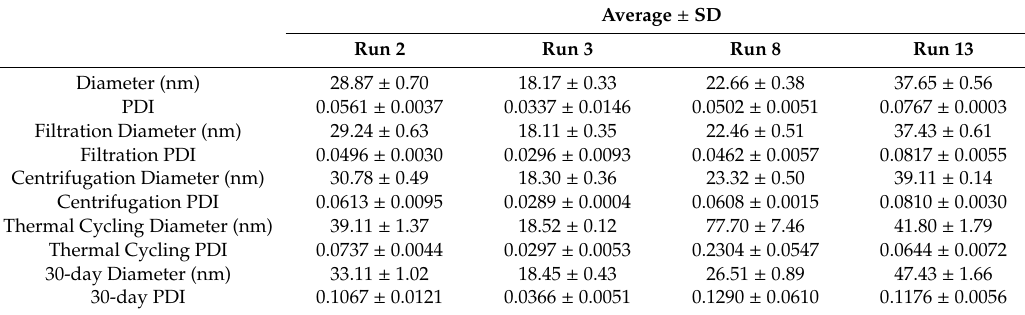
Table 6. Four runs from the screening design of experiments were replicated in triplicate. All CQAs were measured for each replicate.